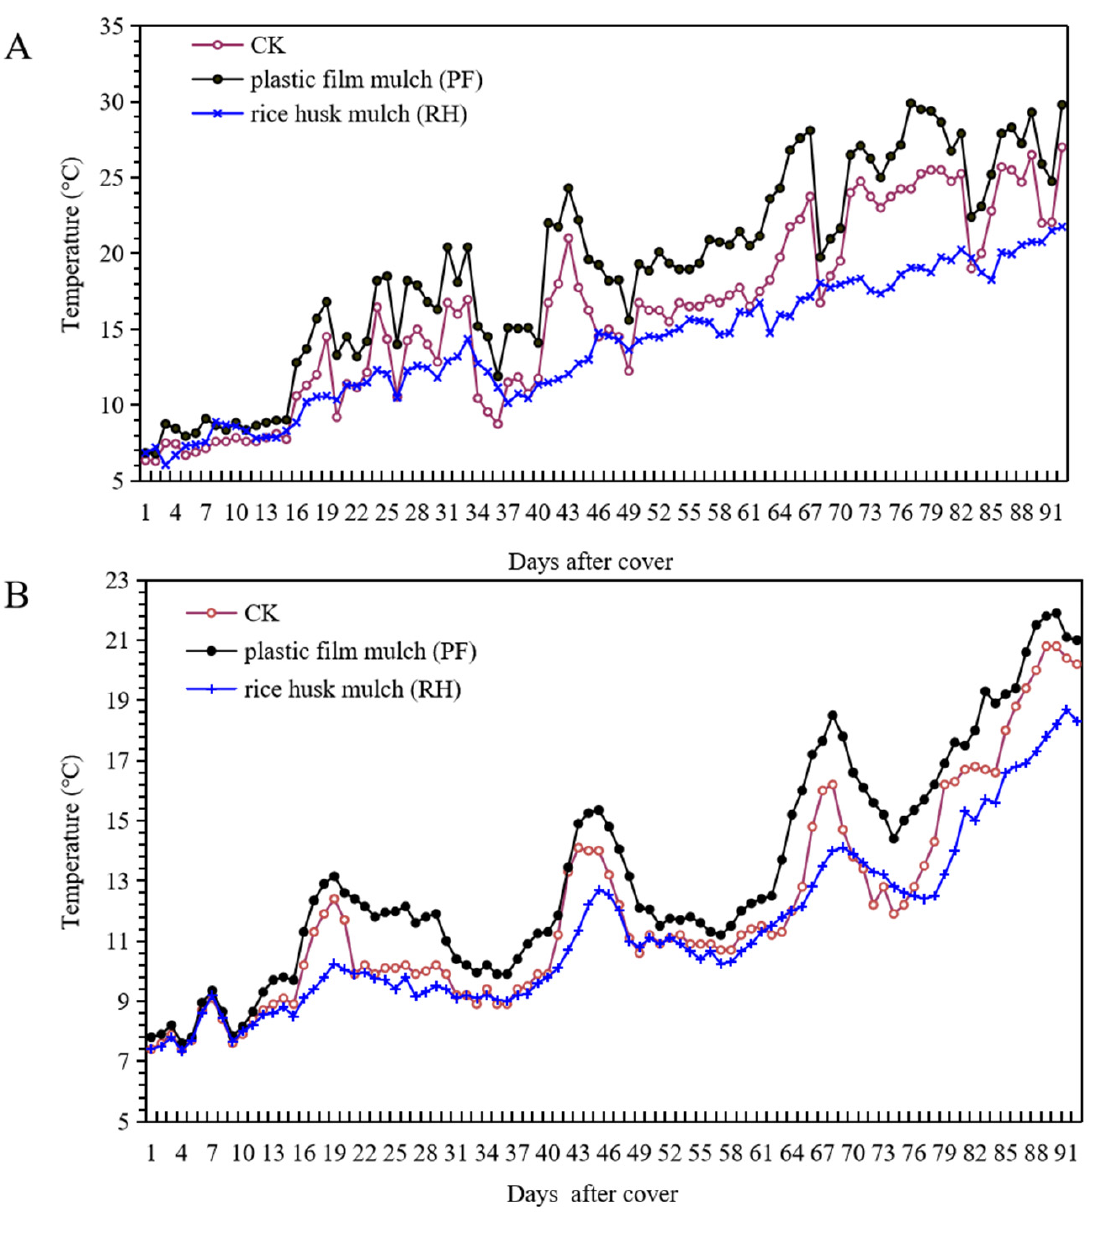
Figure 2. The effect of mulching on the soil surface temperature ( A ), and soil temperature at a depth of 10 cm ( B ), at 9 a.m. for asparagus grown in the plastic tunnel.